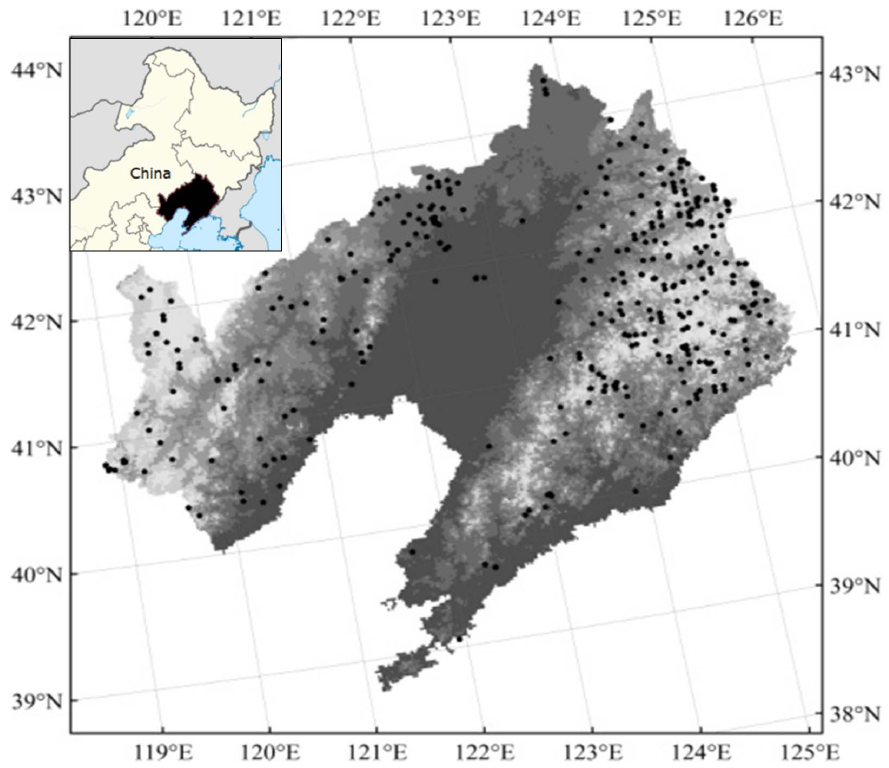
Figure 1. Geographical location, forest flora, and sample sites in Liaoning province.